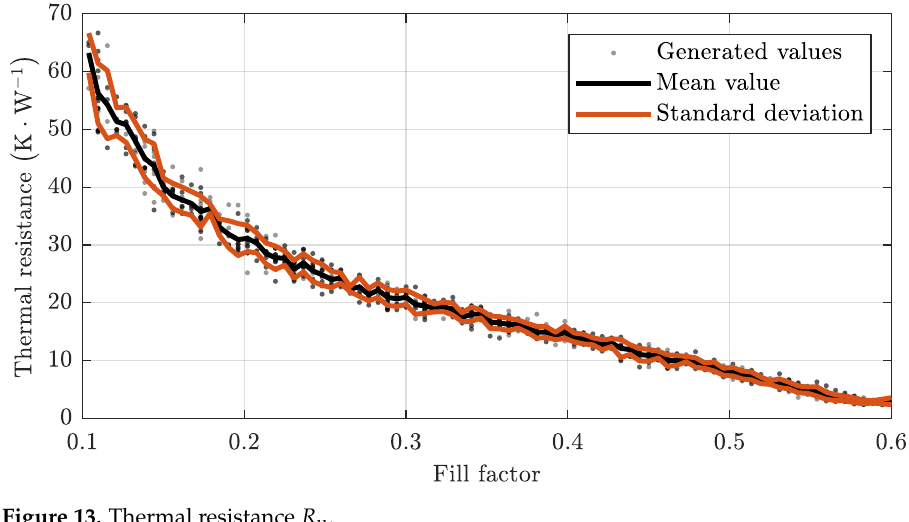
Figure 13. Thermal resistance R u .